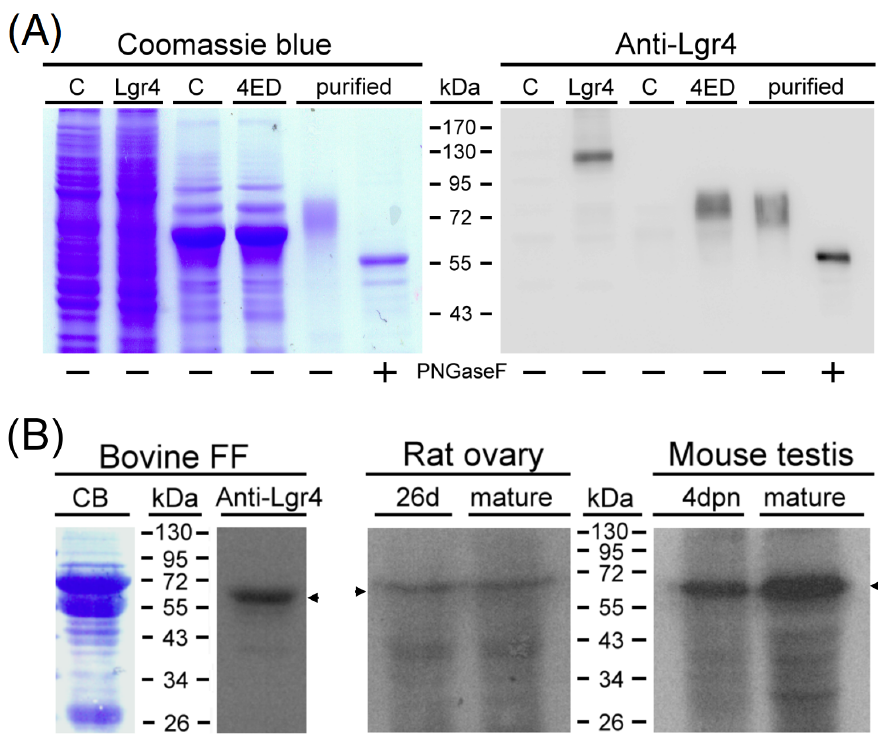
Figure 2. Recombinant and endogenous expression of the Lgr4-ED proteins. (A) SDS-PAGE analysis of full-length rat Lgr4 in transfected 293T cells and recombinant N-terminal FLAG-tagged rat Lgr4-ED (4ED) secreted by transfected 293T cells. C: cells transfected with control pcDNA3.1. Purified Lgr4-ED was further treated without or with PNGase F to characterize its glycosylated nature. The gels were stained using Coomassie blue (left panel) or probed with the anti-Lgr4 antibody (right panel). To adjust the band signals, 1.5 m g and 0.015 m g of purified Lgr4-ED before or after de- glycosylation was loaded for Coomassie blue staining and Western blotting, respectively. (B) Detection of the endogenous Lgr4-ED protein signals in different species. Bovine follicular fluid (FF) and the homogenized supernatants from rat ovaries and mouse testes were subjected to SDS-PAGE and Western analysis against Lgr4. CB, Coomassie blue staining; dpn, days postnatal.